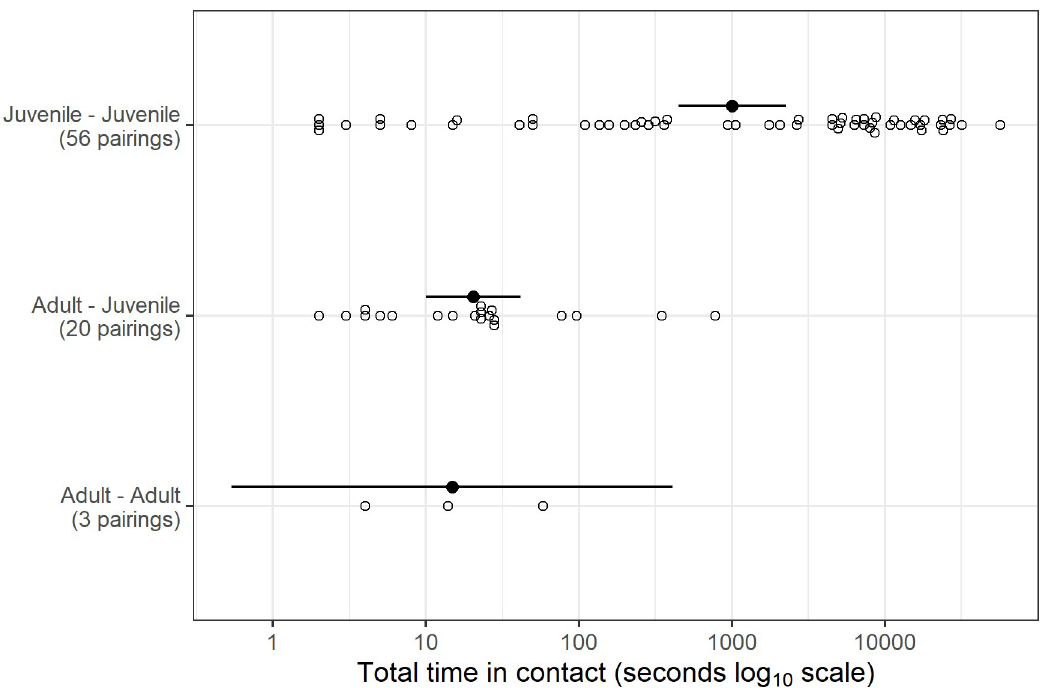
Fig 3. Graphical representation of individual rabbits and pairings between logger pairs (n = 79). Each social group is made up of nodes (circles indicating logger identification number) and connecting lines between nodes. Node colours indicate warren of capture and node size indicates rabbit age class (adult and juvenile). Edge thickness (10 seconds- 5000 seconds) is proportional to total time in pairing (log 10 scale).